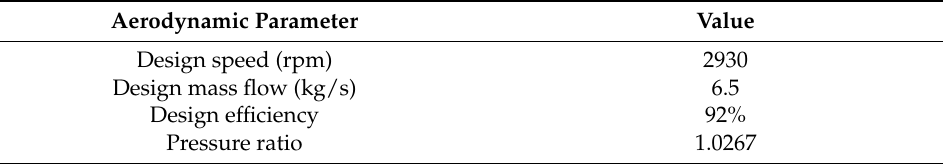
Table 1. The aerodynamic design parameters of TA36